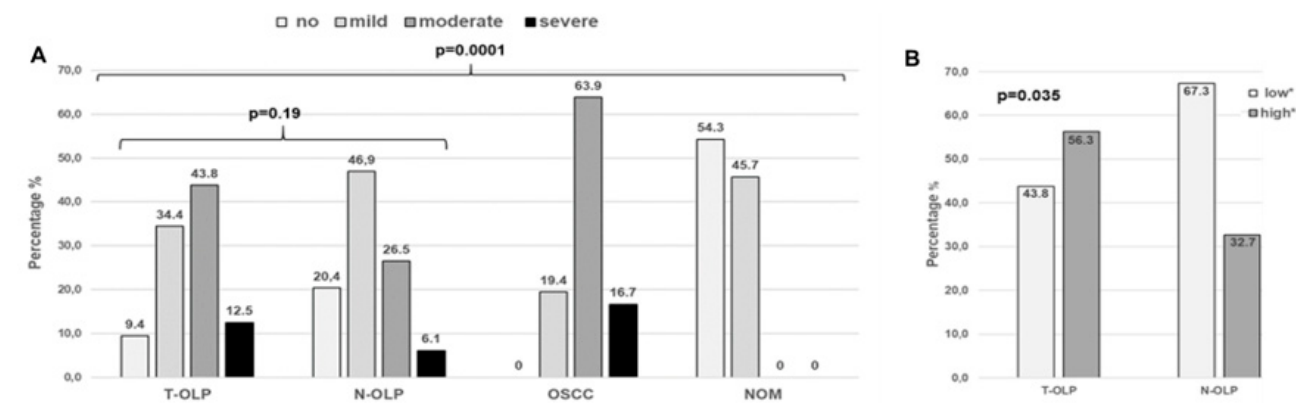
Figure 6. Association between inflammation and malignant transformation or malignancy, respectively. There was a statistical significant association between malignancy but not between malignant transformation and inflammatory infiltration over all groups of inflammatory degrees ( A ). If OLP were grouped into high and low infiltration by inflammatory cells a significant association between inflammation and malignant transformation could be shown. ( B ). * Group of no and mild inflamed; ** high inflammation (moderate/high).